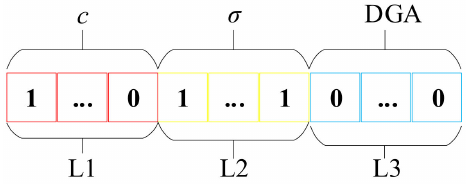
Figure 4. The binary encoding of